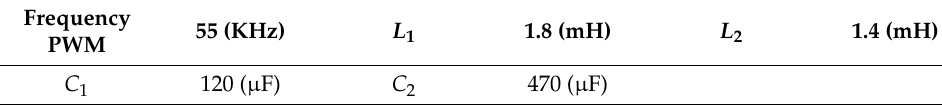
Table A2. Converter parameters.